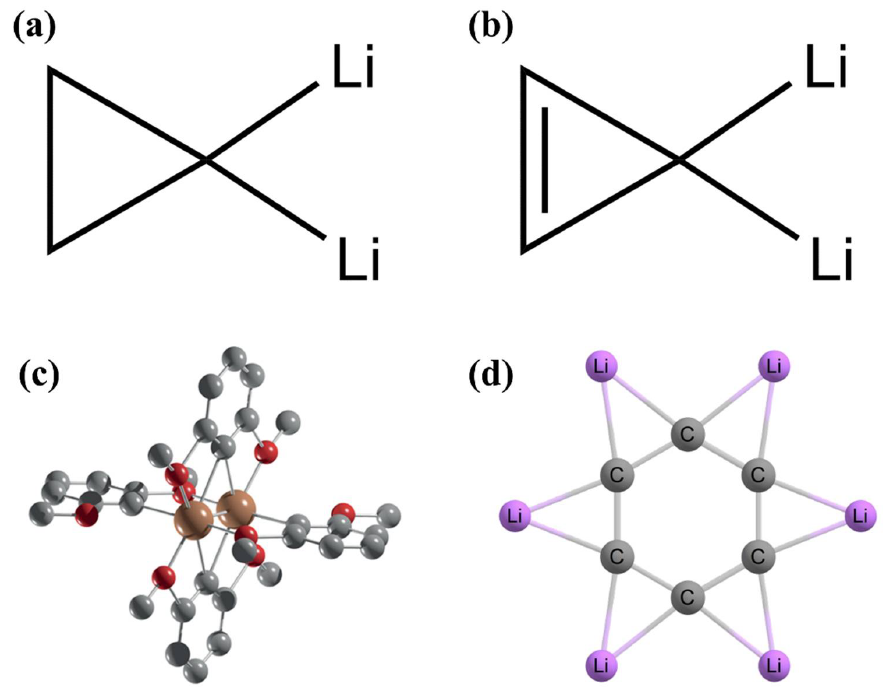
Figure 2. Optimized geometries of ( a ) 1,1-dilithiocyclopropane and ( b )